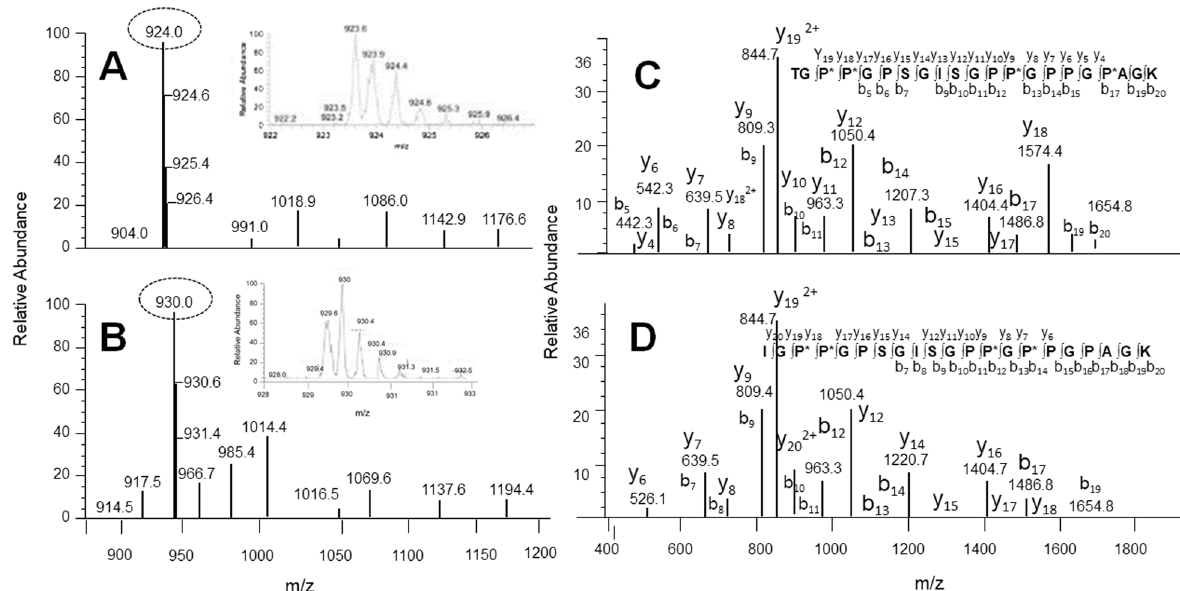
Fig. 3 (left) Mass spectra and inset spectra of a digested bovine gelatin (m/z 924) and b digested porcine gelatin (m/z 930); (right) MS spectrum of c m/z 924.0 conformed to the TGP*P *GP SGISGPP*GPPGP*AGK sequence and d MS fragments of m/z 930.0 assigned to the IGP*P*GPSGISGPP*GP*PGPAGK sequence. Note the asterisks (*) represent hydroxylation sites. Zhang et al. (2009) Copyright (2009) with permission from